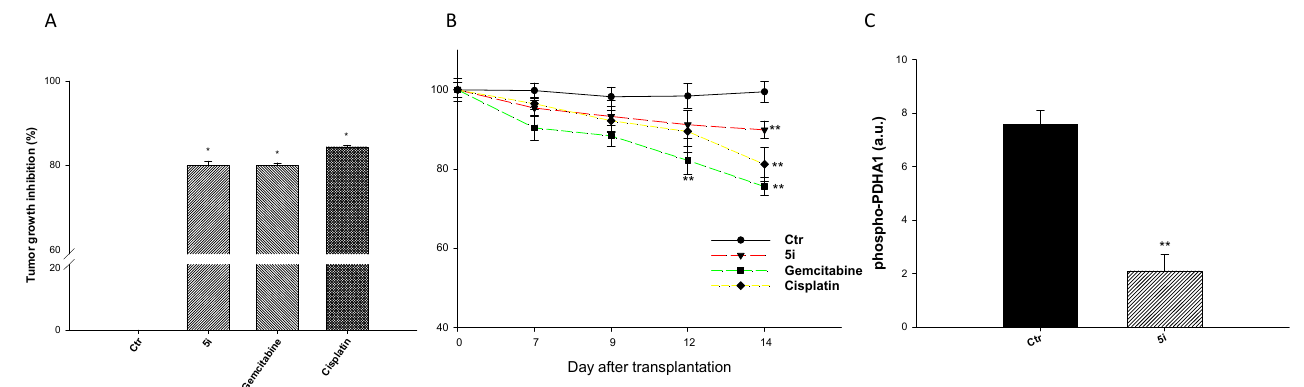
Figure 11. ( A ) Inhibition of tumor growth; days 7 − 14: animals received daily i.p. of 5i (20 mg kg − 1 in vehicle solution), gemcitabine (60 mg kg − 1 in 0.9% saline solution) or cisplatin (3 mg kg − 1 in saline solution). On day 15, animals were sacrificed. ( B ) Body weight changes of LLC-bearing C57BL mice treated with the vehicle or the tested compounds. ( C ) Evaluation of p-PDHA1 in tumor samples of treated mice. Phosphorylation level of S232 PDH E1 alpha protein (PDHA1) assessed by ELISA Kit (ab115343). Error bars indicate SD. * p < 0.05, ** p < 0.01.